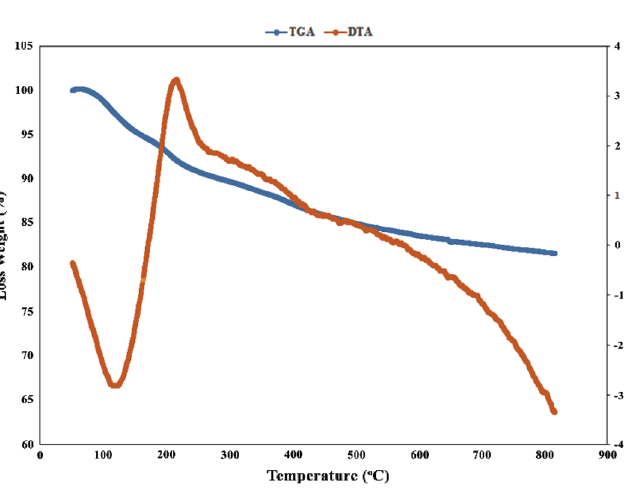
Figure 7. The BET for Go/f-SiO 2 ( a ), Go/f-SiO 2 /Co ( b ), and BJH for Go/f-SiO 2 /Co ( c ).